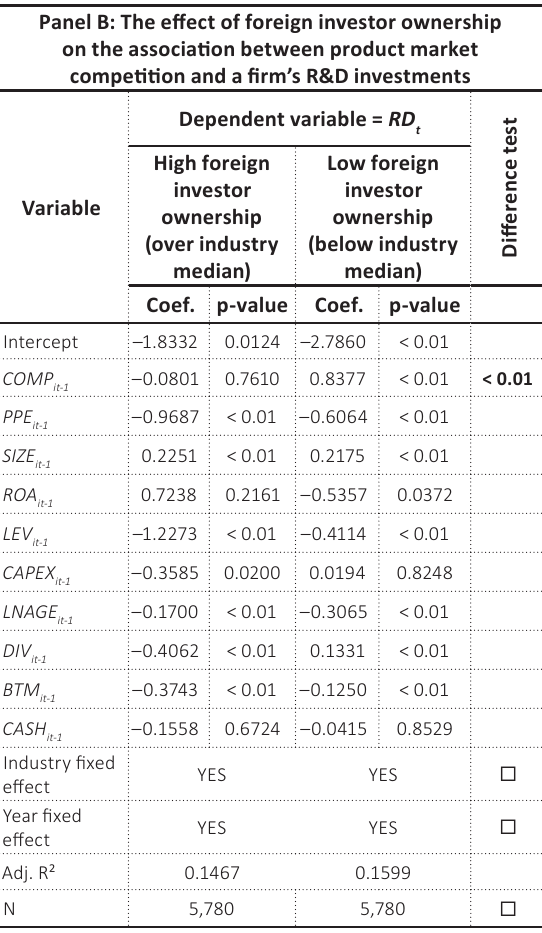
Table 4 (cont.). The effect of internal corporate governance on the association between product market competition and R&D investments Panel B: The effect of foreign investor